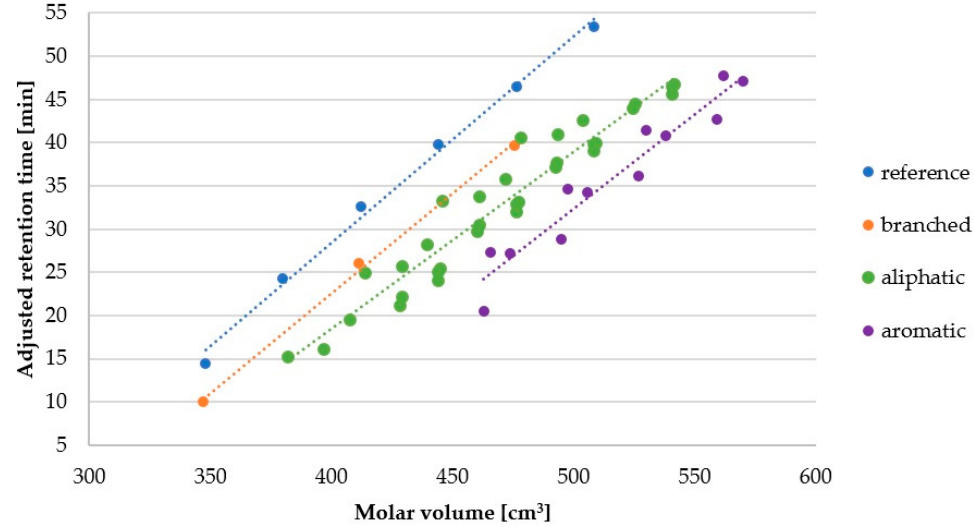
Figure 5. Molar volume of aliphatic ( 7 – 10 , 27 – 30 , 35 – 38 , 43 – 46 , 63 – 74 , 91 – 94 ), aromatic ( 23 – 26 , 95 – 102 ), branched ( 103 – 105 ) and reference ( 1 – 6 ) lipopeptides versus adjusted retention time.